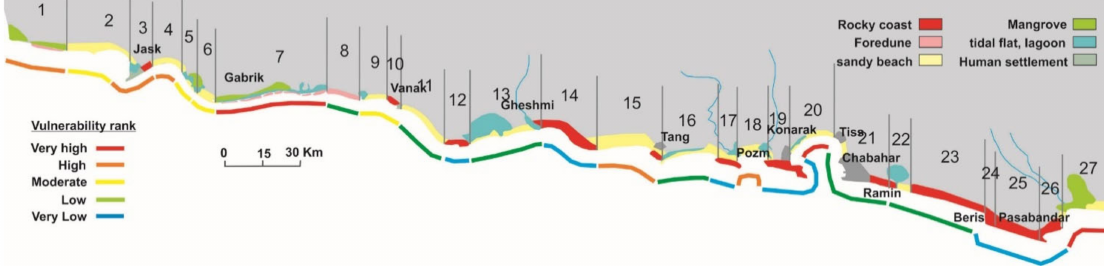
Figure 10. Coastal segments and overall risk rating of the Iranian coast of Makran based on CVI calculations. Table 3. Coastal vulnerability to sea level rise based on the risk variables. Coastal Segment